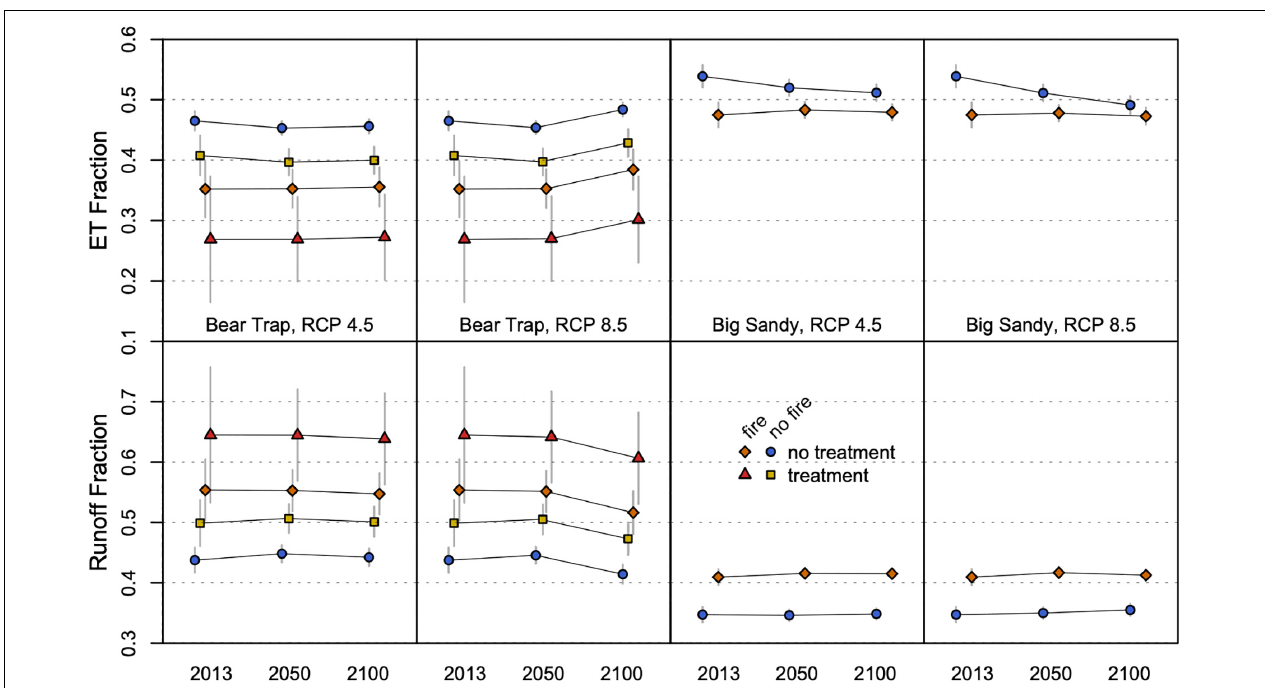
FIGURE 3 | Simulation results of the runoff and evapotranspiration fractions for vegetation scenarios and projected temperature increases in 2050 and 2100. Basin-mean LAI in Big Sandy following treatment, with and without fire, were not different from the no-treatment scenarios and are not shown. Simulations are for water-year 2010–2013 conditions, during which mean precipitation was 1990 mm in Bear Trap and 1300 mm in Big Sandy. Vertical bars indicate the 95% confidence interval based on the multiple parameter sets for each